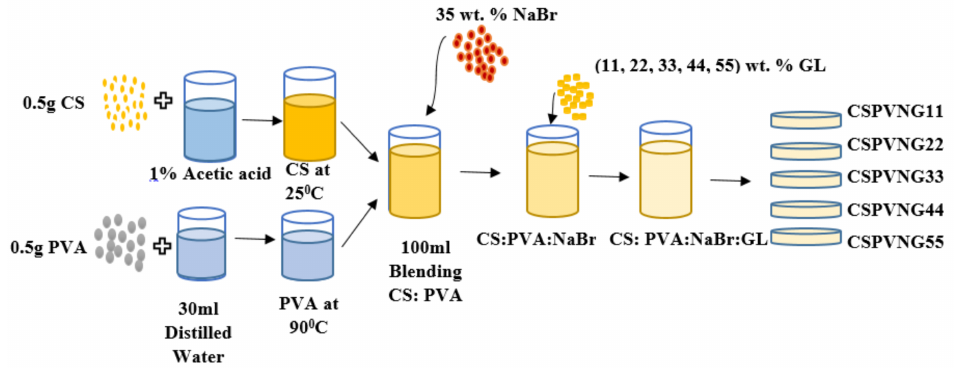
Figure 16. Schematic processes for the fabrication of the plasticized PE samples.